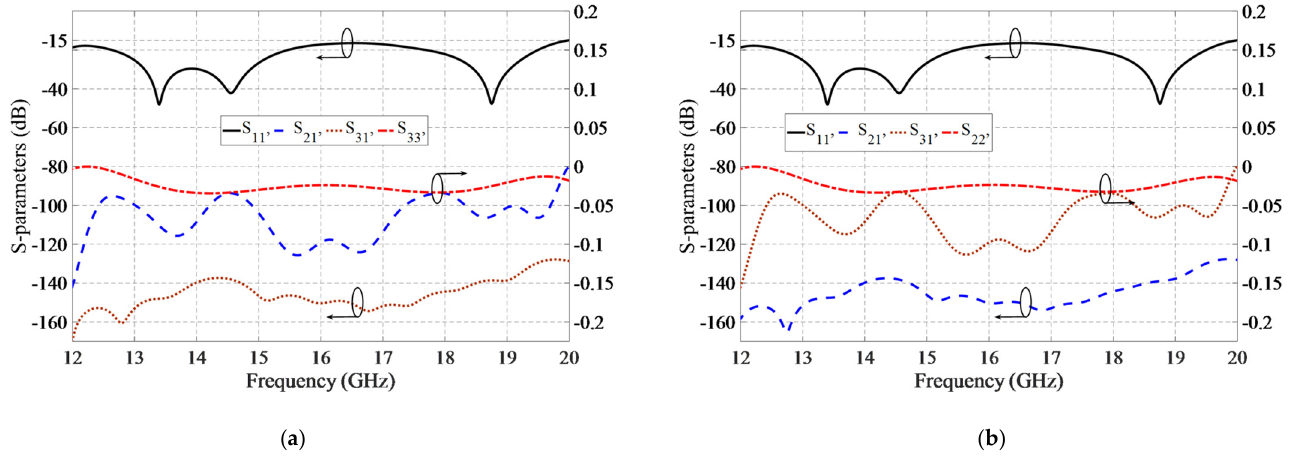
Figure 6. The simulated S-parameters of the microwave switch in ( a ) State A and ( b ) State B.